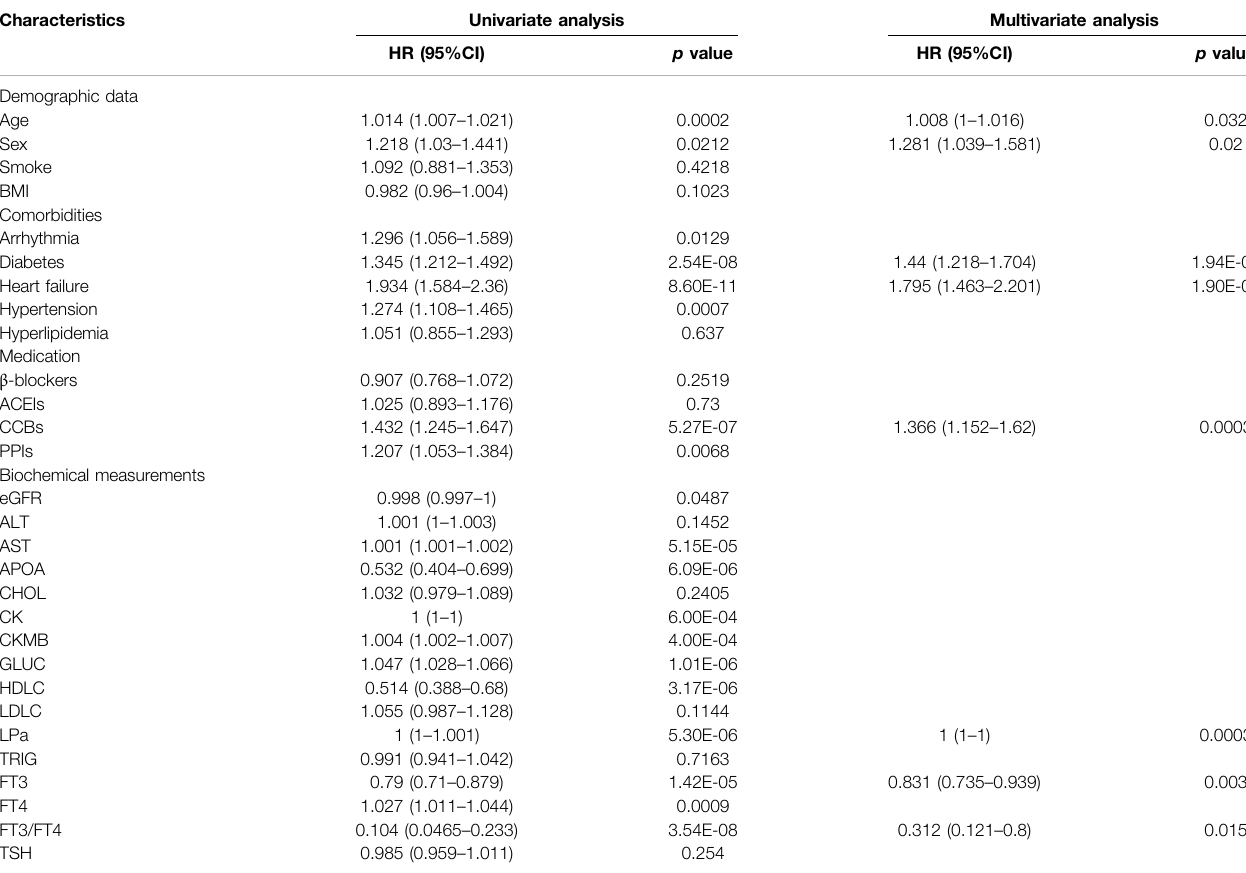
TABLE 3 | Cox proportional hazards analysis for